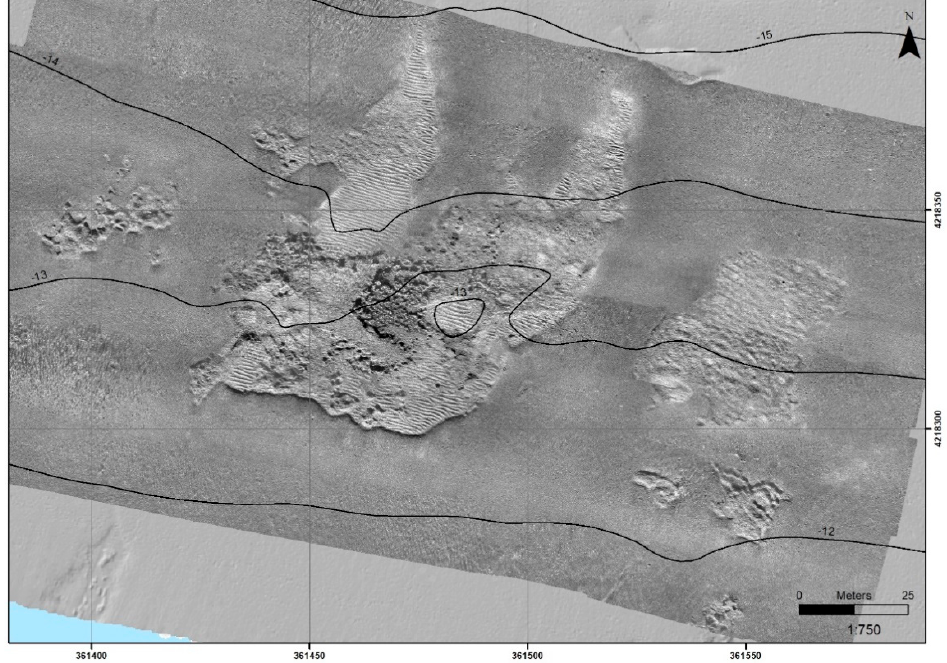
Figure 2. Side Scan Sonar mosaic. There are sandy bottoms with different granulometry, ripple marks covering dead matte and dead matte outcrops where natural and transplanted P. oceanica patches are established (see Figure 3).